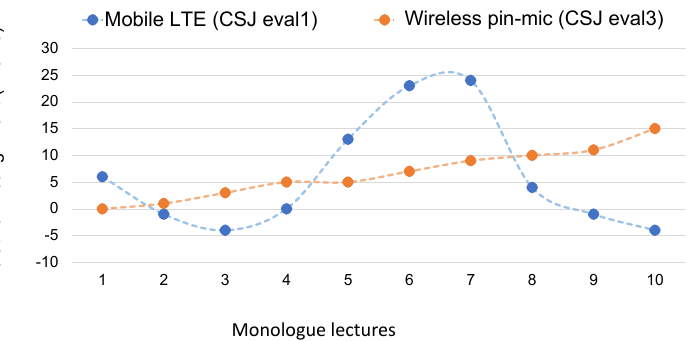
Figure 2. Misalignment analysis of re-recorded speech for mobile LTE and wireless pin mic